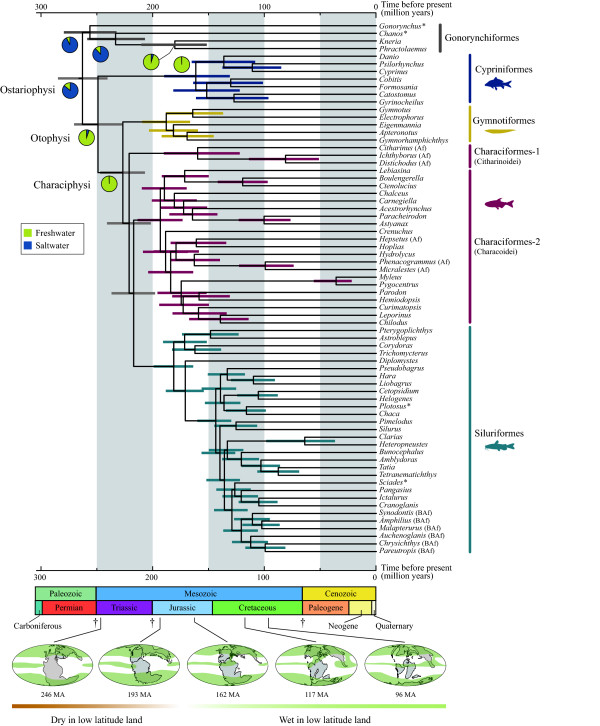
Timetree derived from the Bayesian relaxed-molecular clock method (only ostariophysan portions shown). Horizontal bars indicate 95% credible intervals of the divergence time estimates. ML reconstruction of ancestral habitats are indicated on selected nodes with pie charts showing the likelihoods for two character states (blue, freshwater; light green, saltwater). African characiforms and Big African clade in Siluriformes reported by Sullivan et al. [21] are denoted by "Af" and "BAf", respectively. All marine species are indicated by asterisks. Dagger symbols indicate the three big mass extinction events after 300 Ma. Paleocoastline maps [126] are shown below the timetree with moist zones schematically illustrated by green [127].